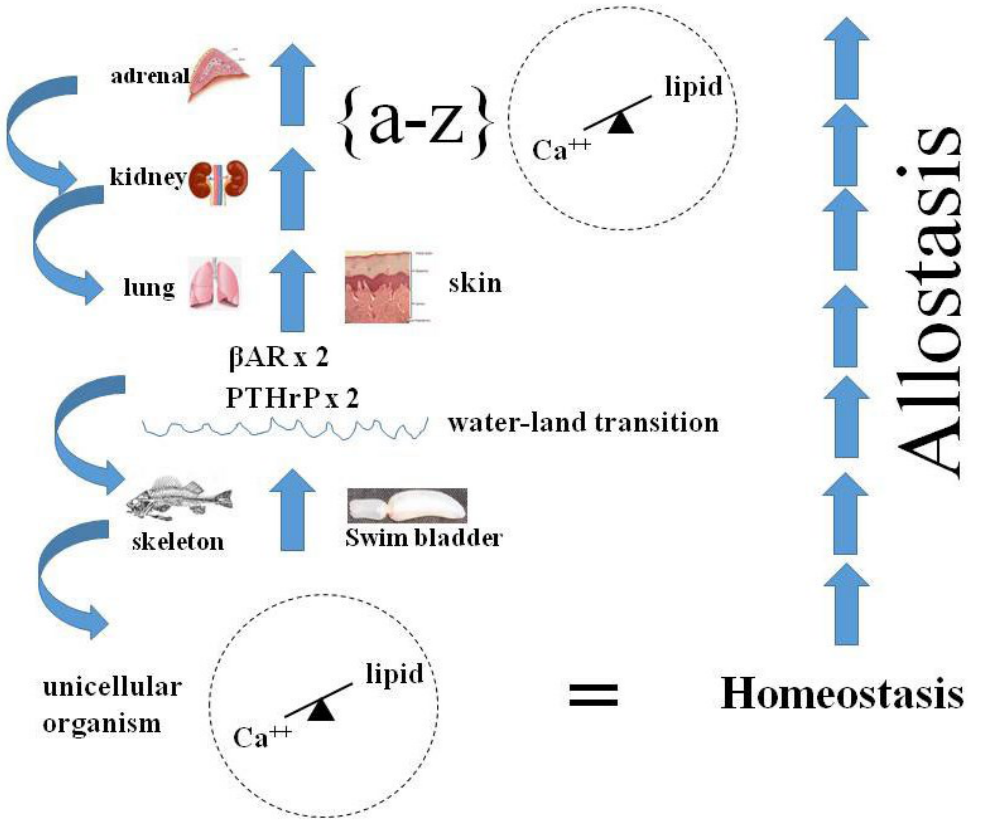
Figure 4. Physiologic Adaptation. The ontogenetic and phylogenetic integration ( ∫ ) of calcium-lipid homeostasis, from unicellular organism incorporation of lipid into the plasma lemma to multicellular organism calcium/lipid epistatic homeostasis fostered the Evolution of metazoans. This figure, focuses on the specific stress of the water-land transition on the Evolution of a wide variety of organs-bone, lung, skin, kidney, adrenal-resulting from the duplication of the PTHrP Receptor gene in fish, followed by the βAdrenergic Receptor (βAR) gene, culminating in integrated physiology, or allostasis (on far right). Internal selection was mediated through selection pressure on homeostatic mechanisms mediated by paracrine cell-cell interactions; as vertebrates adapted to land, the PTHrP signaling mechanism iteratively allowed for physiologic adaptations to air breathing (skin, lung), prevention of dessication (skin, kidney) and ‘fight or flight’ (adrenal). The blue arrows on the far left signify how evolved traits refer back to their antecedents, or are